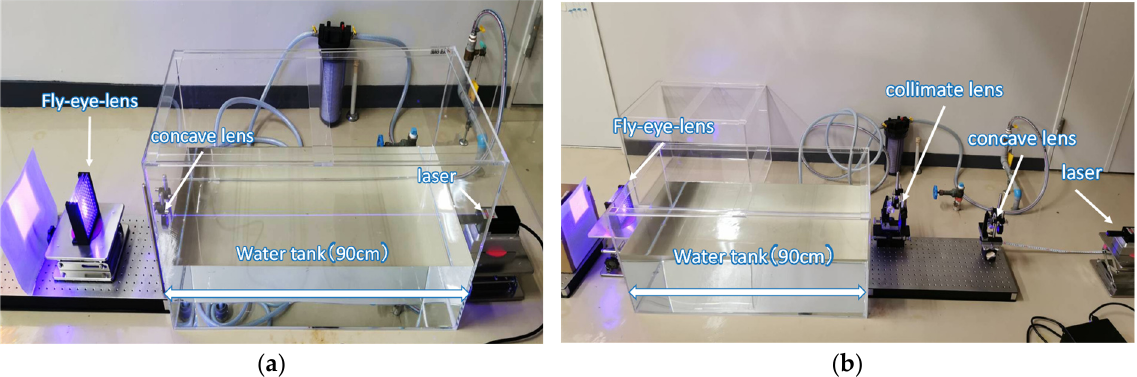
Figure 5. ( a ) System with concave lens on the solar cell side and ( b ) system with concave lens on the laser side. laser